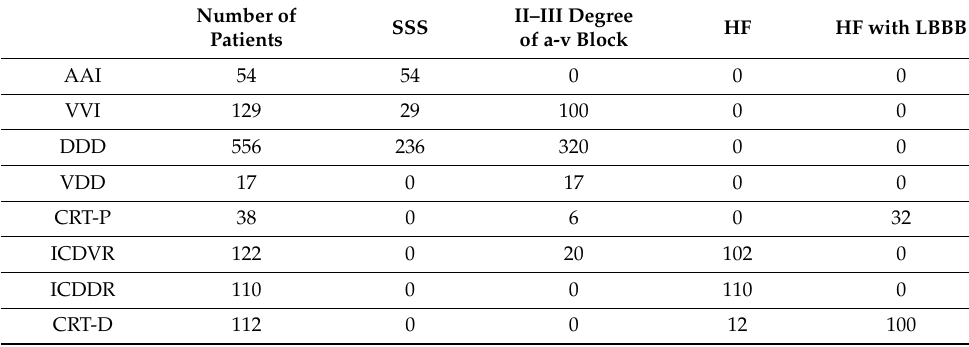
Table 1. Indications for initial implantation of